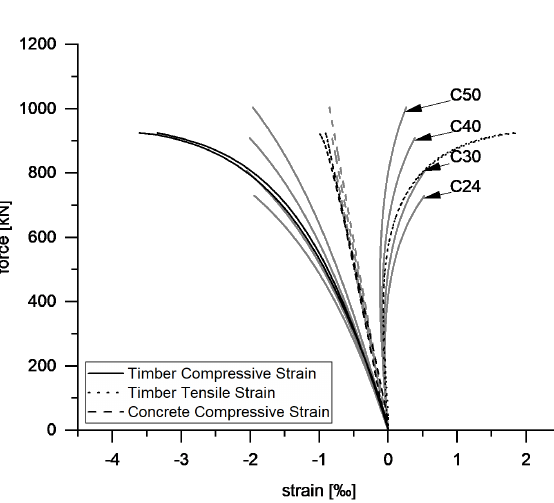
Figure 11. Development of strains at the vertical wall centre for timber and concrete calculated (gray) and experiment (black).